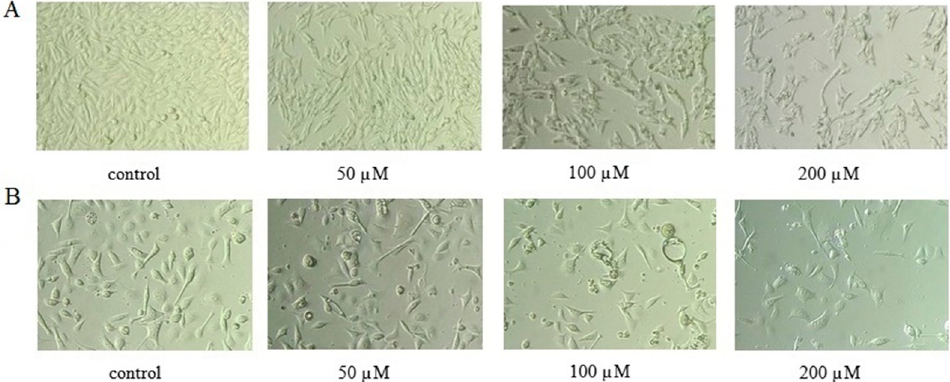
Figure 2. Morphological changes of HGC-27 and AGS cells treated with AT-II for 48 h and observed with an inverted microscope ×200 magnification. ( A ) HGC-27 cells; ( B ) AGS cells.